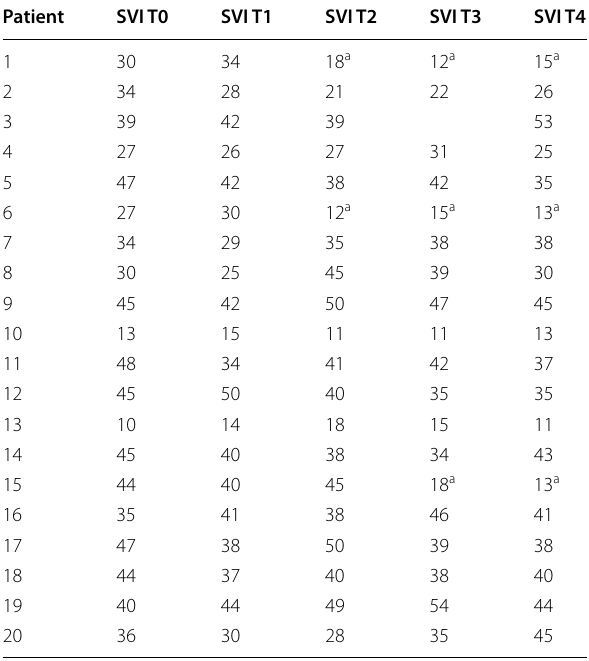
Table 3 Group I Patient Stroke Volume Indices (SVI) T0-T4